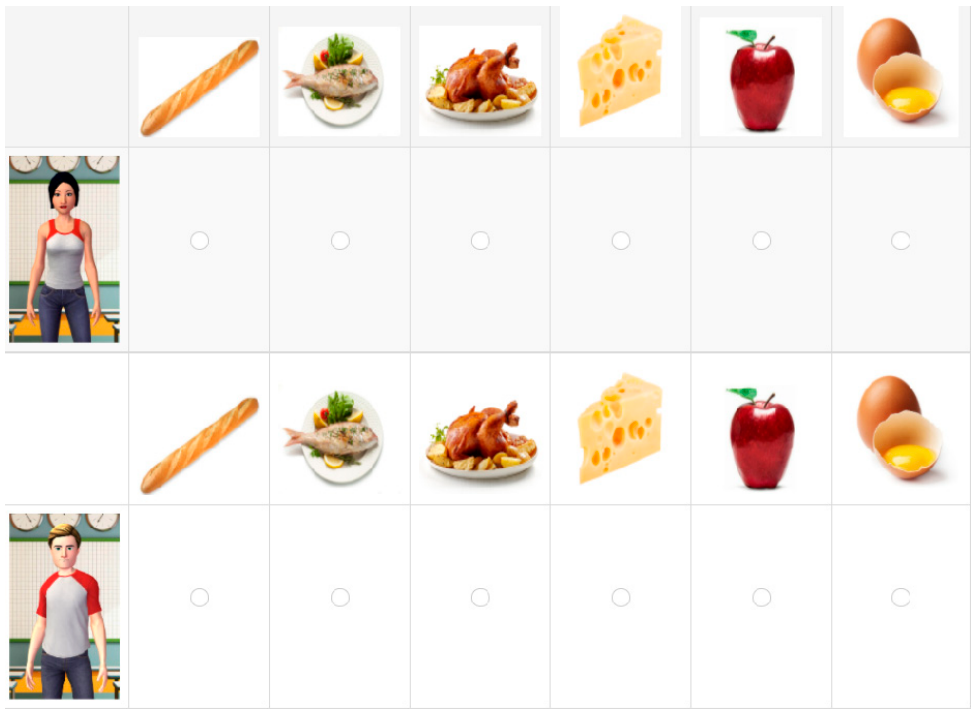
Figure 1. Example of the presentation of a male and a female avatar in the food assignation item.